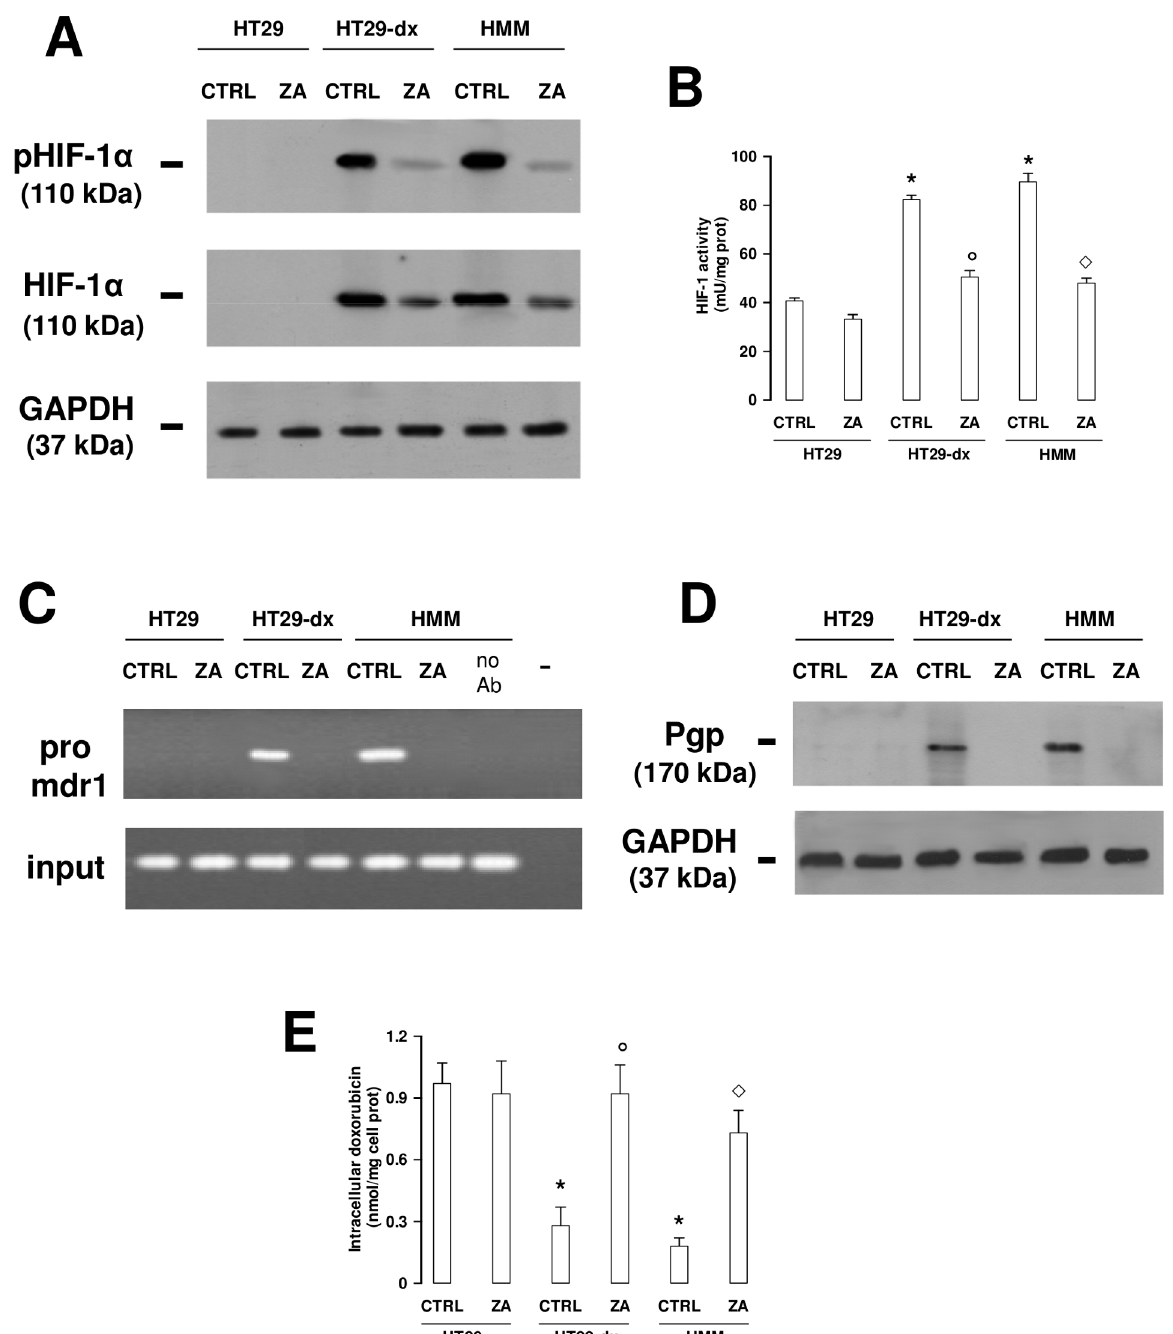
Figure 3. ZA-induced inhibition of HIF-1 a activity and Pgp expression in MDR + cancer cells. A . Detection of phosphorylated (pHIF-1 a ) and total HIF-1 a in MDR 2 HT29, and MDR + HT29-dx and HMM cells after 48-hour incubation without (CTRL) or with 1 m mol/L ZA (ZA). B . HIF-1 activity was higher (*p , 0.001) in MDR + HT29-dx and HMM cells than HT29 cells. After ZA treatment (as reported in A ), a significant decrease of HIF-1 activity was observed in HT29-dx ( u p , 0.001) and HMM cells ( e p , 0.001). C . Chromatin immunoprecipitation of HIF-1 a on mdr1 promoter in MDR 2 and MDR + cells, treated as reported in a . pro mdr1 : PCR product from immunoprecipitated samples. Input : PCR product from non immunoprecipitated samples (genomic DNA). no Ab : samples incubated in the absence of anti-HIF-1 a antibody. ‘‘-’’: blank. D . Western blotting detection of Pgp in cells treated as described in A . E . Intracellular doxorubicin was measured spectrofluorimetrically: significantly lower concentrations were detected in HT29-dx and HMM vs HT29 cells (*p , 0.002), significantly higher concentrations in ZA-treated cells vs untreated (CTRL) counterparts (HT29-dx: u p , 0.02; HMM: e p , 0.02). The results shown in panels A , C and D are representative of 3 experiments. For panels B and E the bars represent the mean 6 SD of 3 independent experiments.